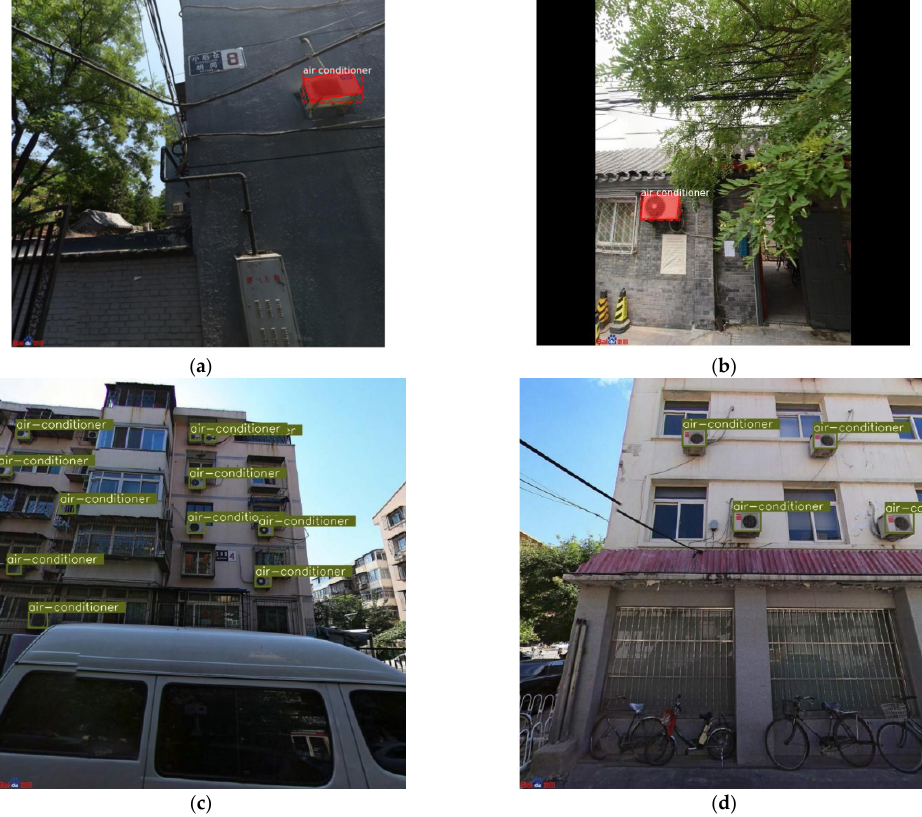
Table 1. Evaluation indexes of generated model files by Mask-RCNN and YOLOv5 algorithms.